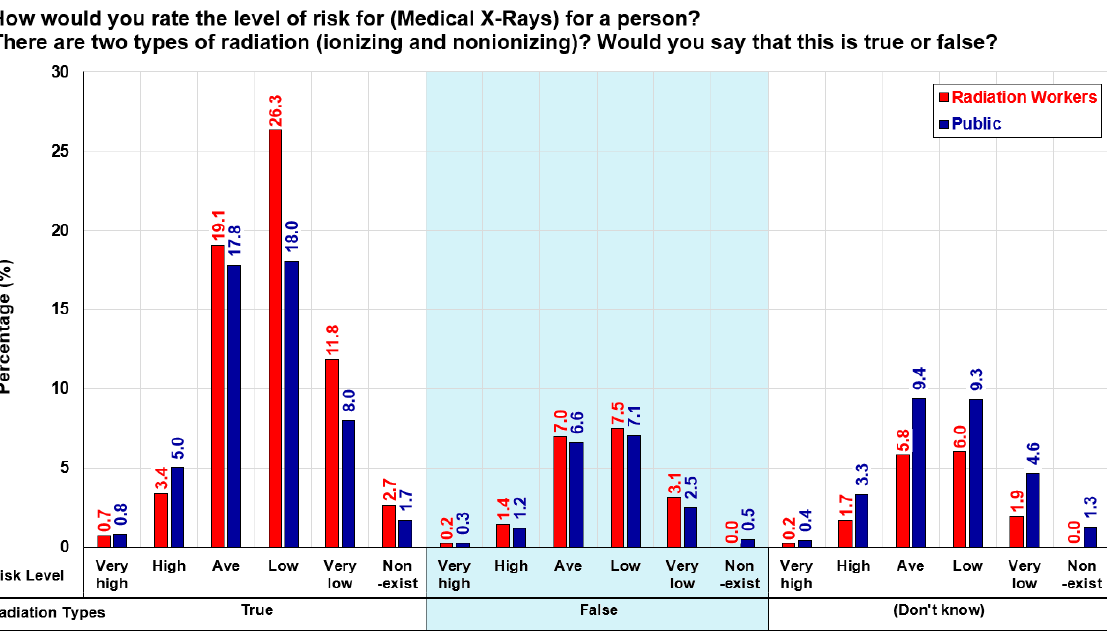
Figure 2. Radiation workers and public ranking of the level of risk for medical X-rays and correct answer regarding two types of radiation.